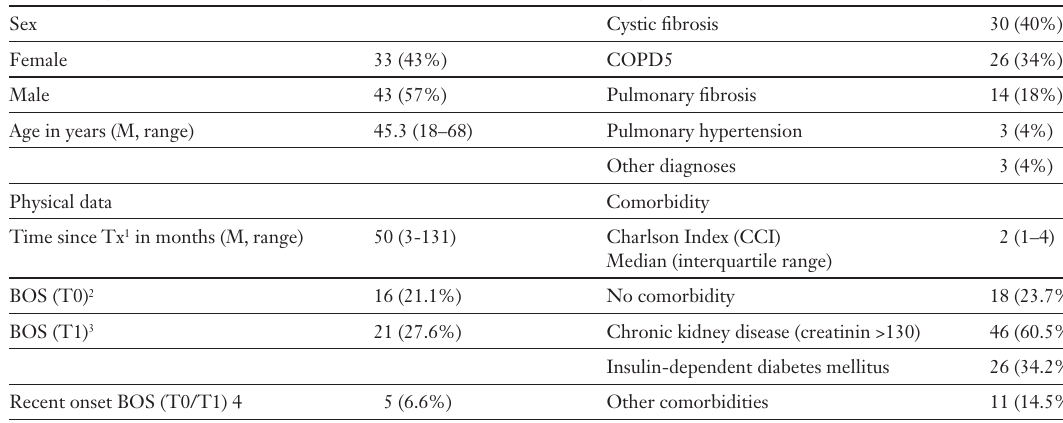
Table 2 Mean values (M) and 95% confidence intervals (CI) of distress/alexithymia and physical parameters (lung function FEV 1 , eNO) atT0, n =